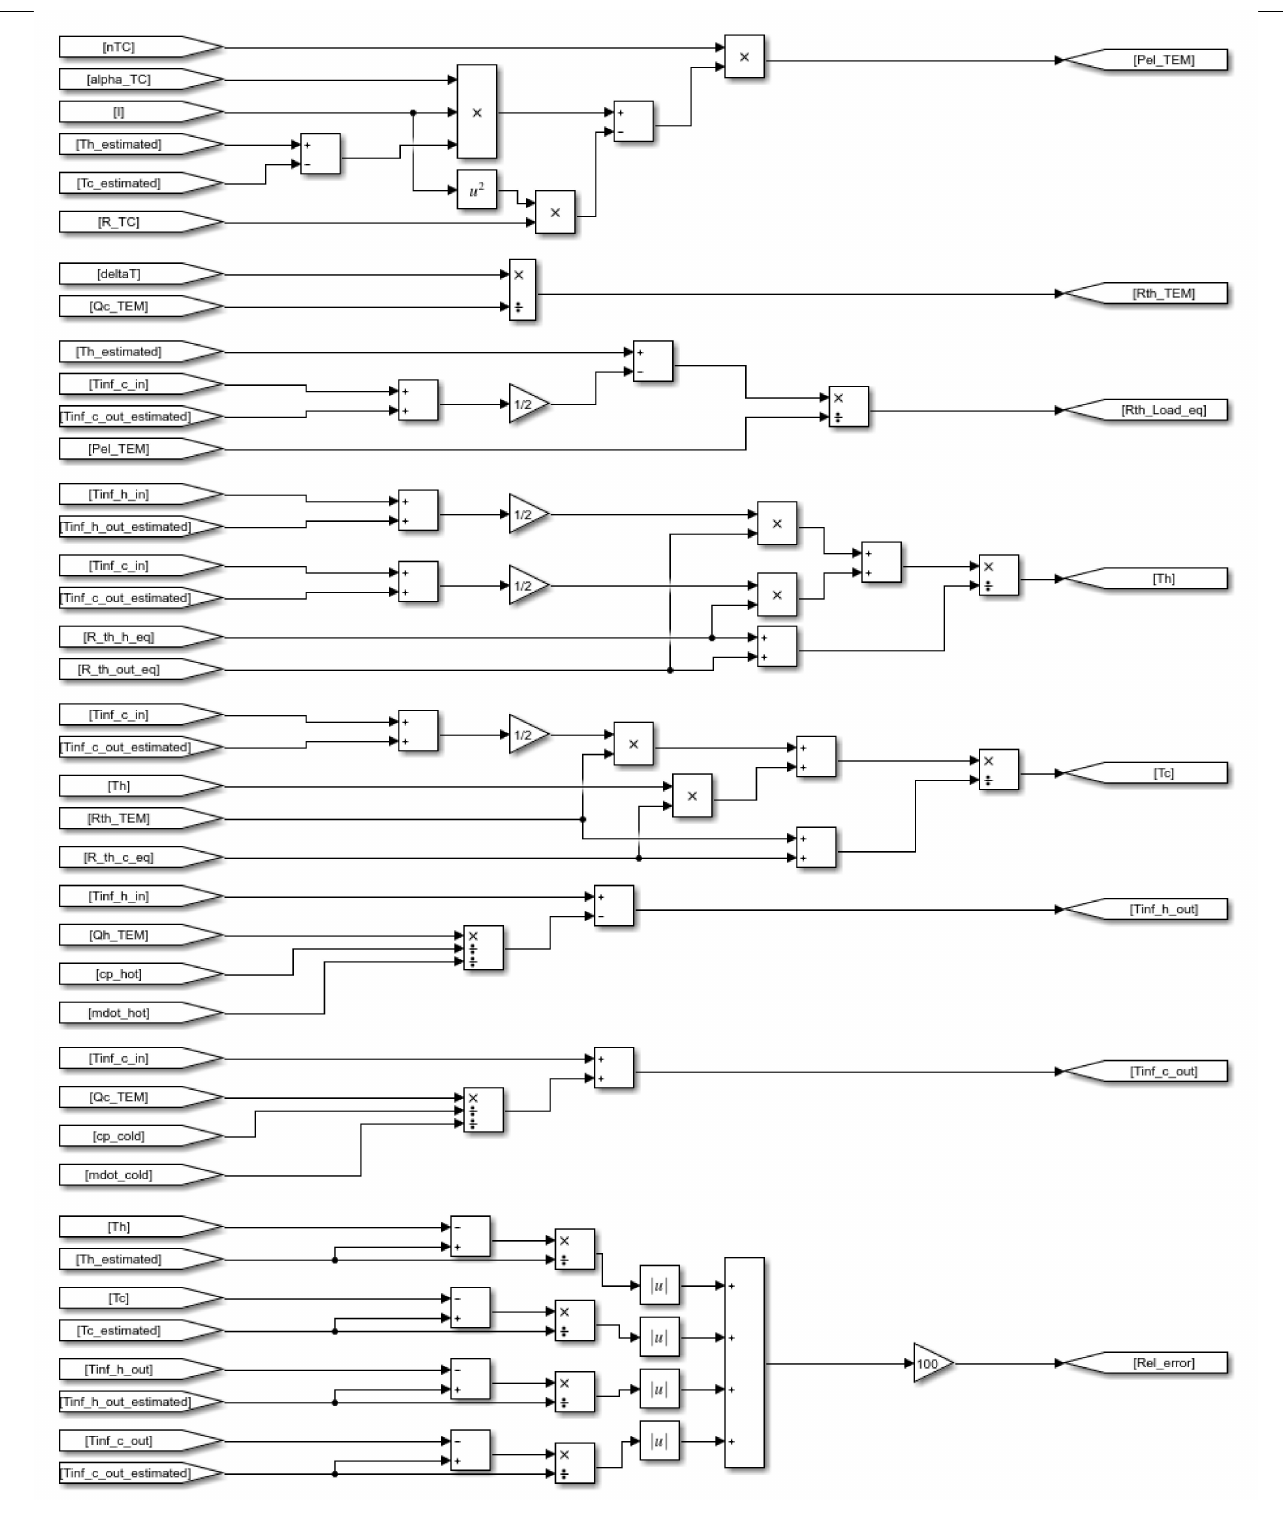
Figure A10. Thermoelectric module block—equations—part